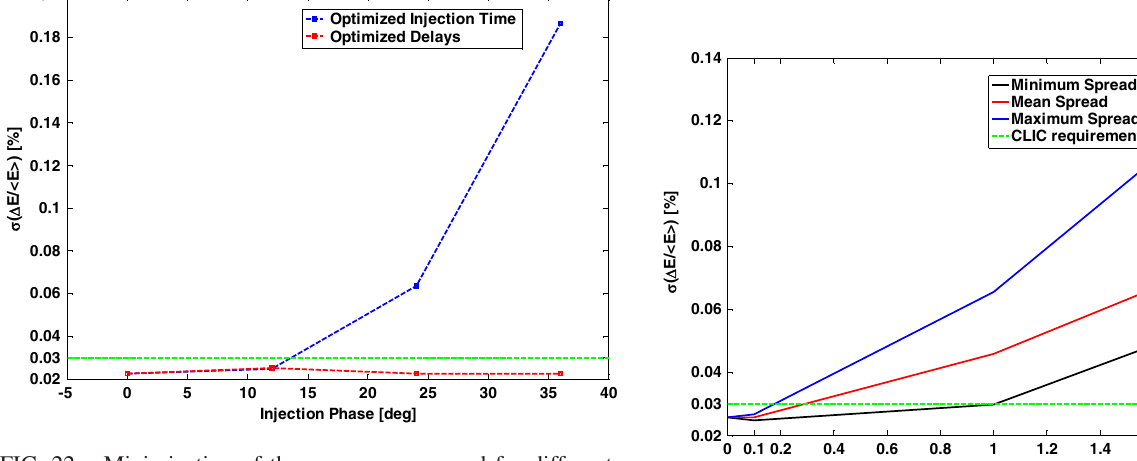
FIG. 22. Minimization of the rms energy spread for different injection phases when using both the switching delays and the injection time (red) and when using only the injection time (blue).